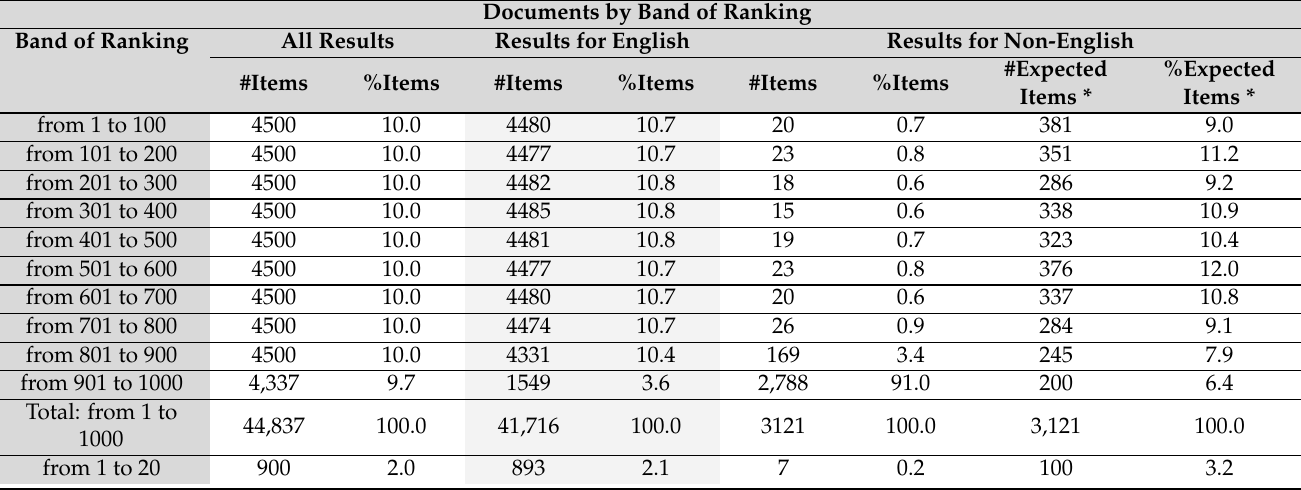
Table 5. Number of documents by band of ranking in the results